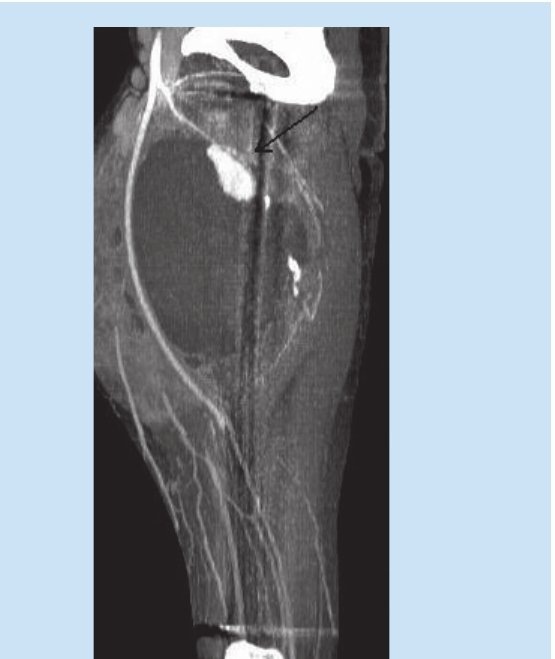
Fig. 2. CT angiography with sagittal multiplanar reconstruction confirms a pseudoaneurysm of the profunda artery